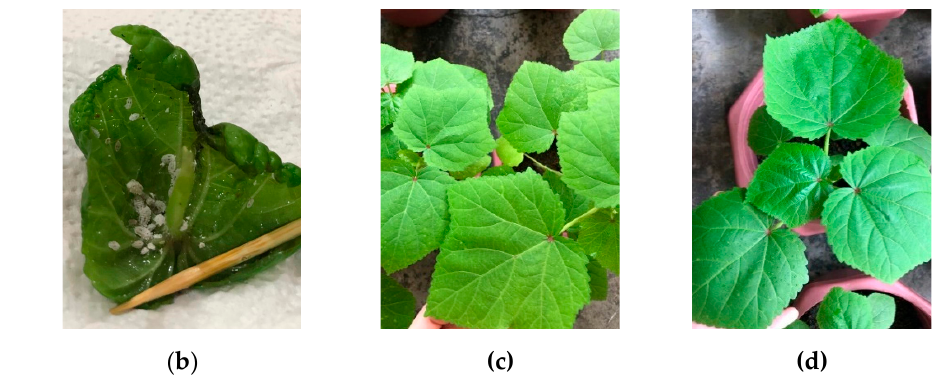
Figure 2. Pictures of leaf conditions observed from different treatment groups. ( a ) White spots on leaves or Powdery mildew from control group; ( b ) Whitefly eggs spotted behind one of the curled leaves from PBA group; ( c ) Big green leaves with minimal white spots in some leaves from GSH group; ( d ) Bigger and darker green leaves from PBA-GSH group.